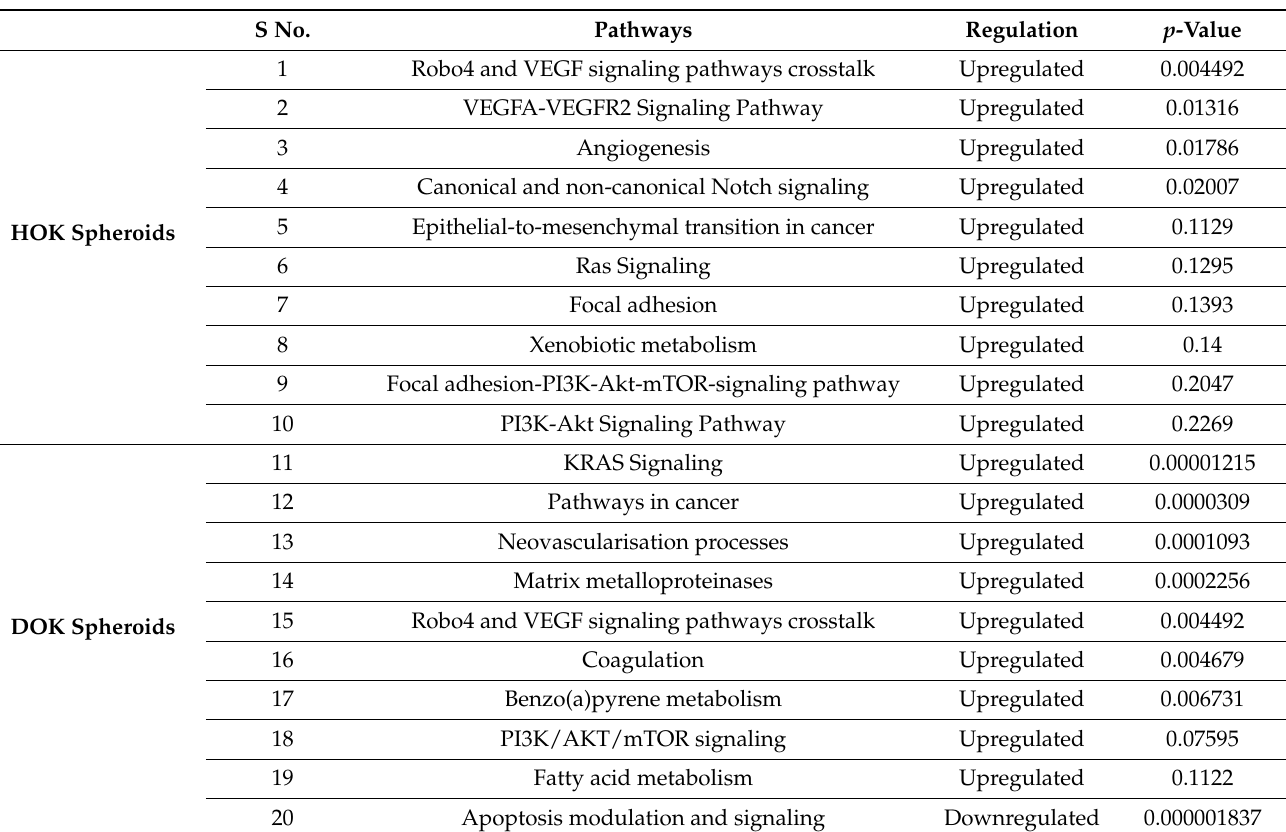
Table 2. Selected pathways enriched by treatment of HOK and DOK spheroids treated with high- dose